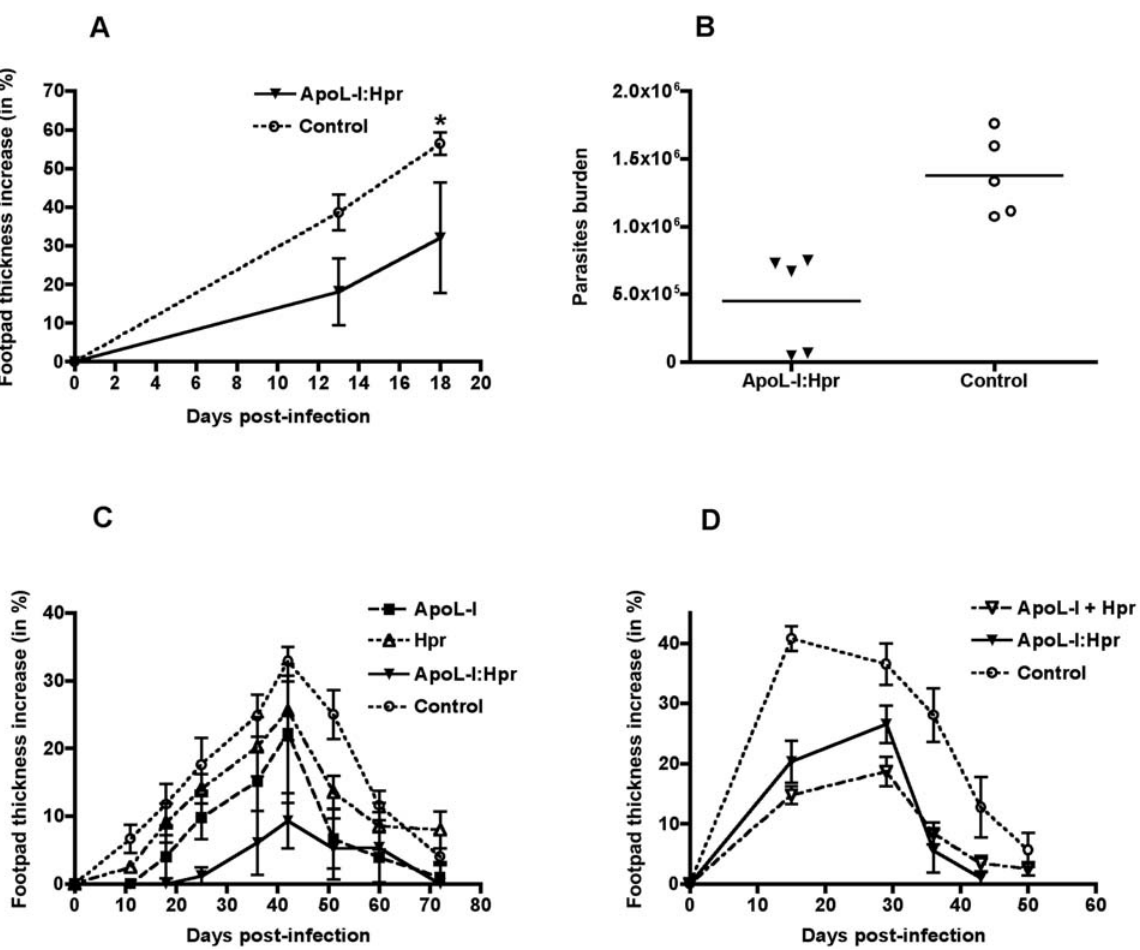
Figure 8. L.major is sensitive to transgenic lytic HDL (TLF) invivo . C57BL/6 mice (5 per group) were subjected to hydrodynamic gene delivery with a single plasmid that encodes for either apoL-I, Hpr, or both apoL-I and Hpr (apoL-I:Hpr), or two plasmids one containing Hpr and one containing apoL-I (apoL-I + Hpr) or vector alone, before subcutaneous infection of the footpad with 1 6 10 6 (A,B) or 0.5 6 10 6 (C,D) L. major metacyclics. The size of the footpad was measured with a caliper (A,C,D). (A and B) represent the data from the same experiment, in which 19 days post-infection, mice were euthanized and footpad parasites were harvested for enumeration by serial dilution assay (B). The data shown represent the mean 6 SD of one typical experiment that has been repeated twice. * p , 0.05, Mann Whitney